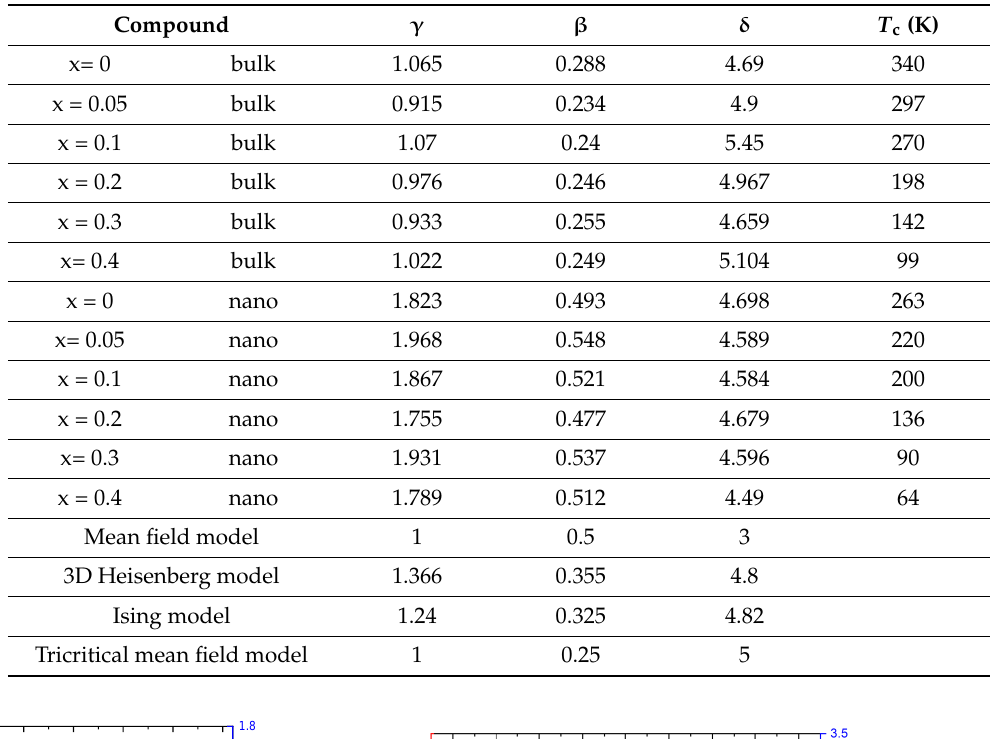
Table 5. Critical exponent values for all samples.